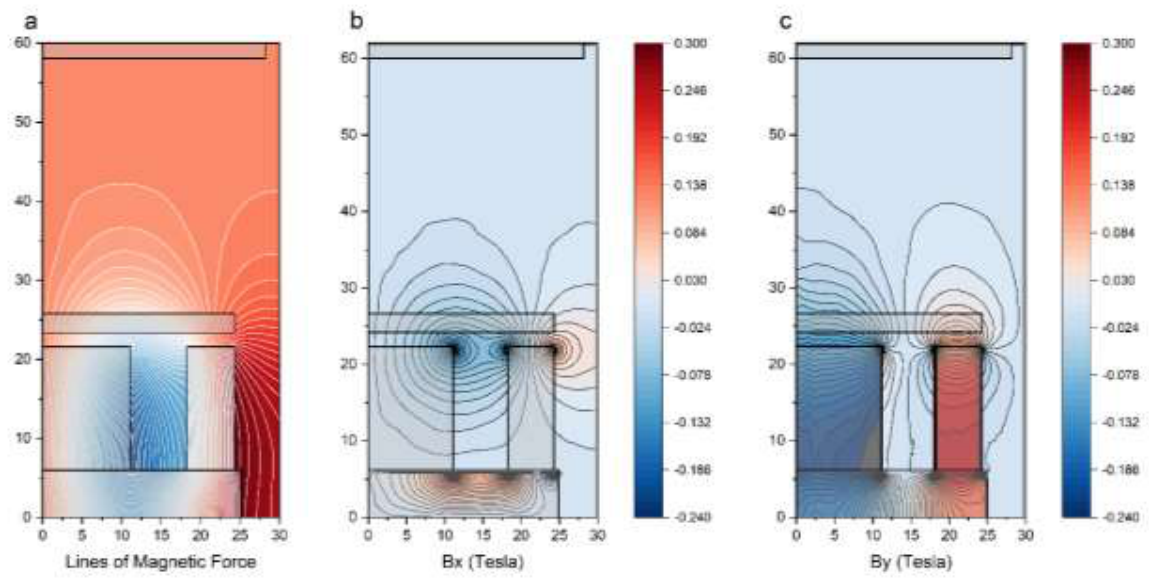
Figure 2 : 2D simulation of the magnetic field inside the chamber of the magnetron source. a) distribution of magnetic force lines around the target. b) contours of the magnetic field strength component Bx. c) contours